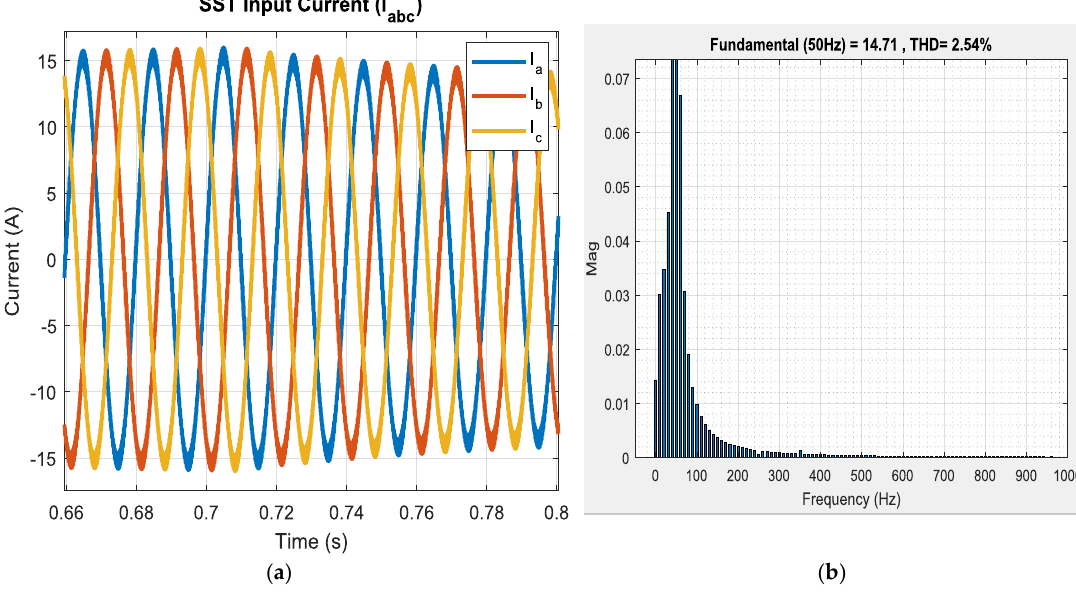
Figure 28. ( a ) SST input current at the grid side. ( b ) THD analysis of phase A input current.